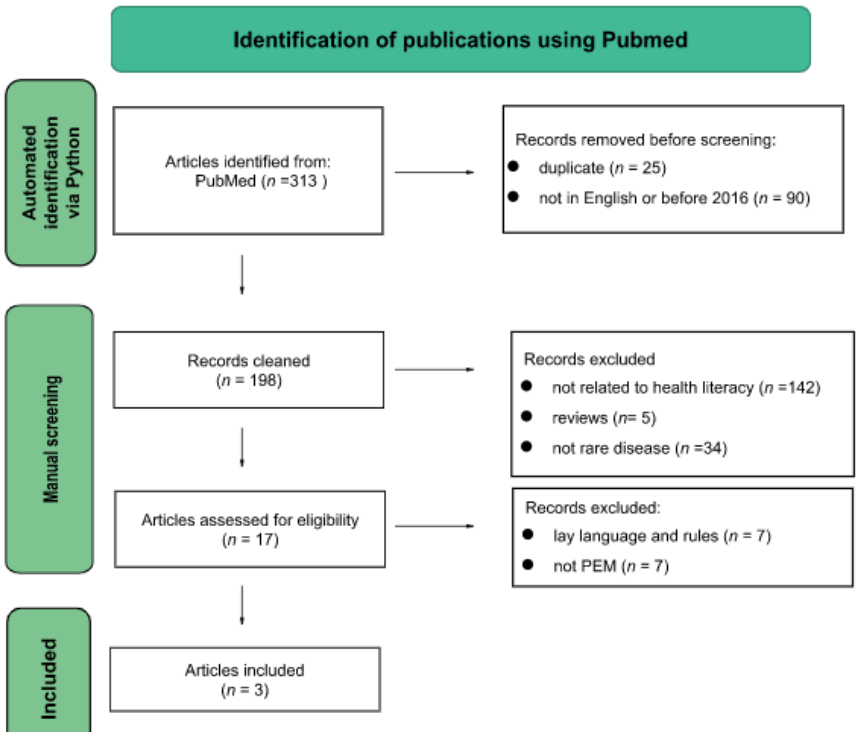
Figure 5. Flow diagram for the literature search which included searches of databases. Only articles